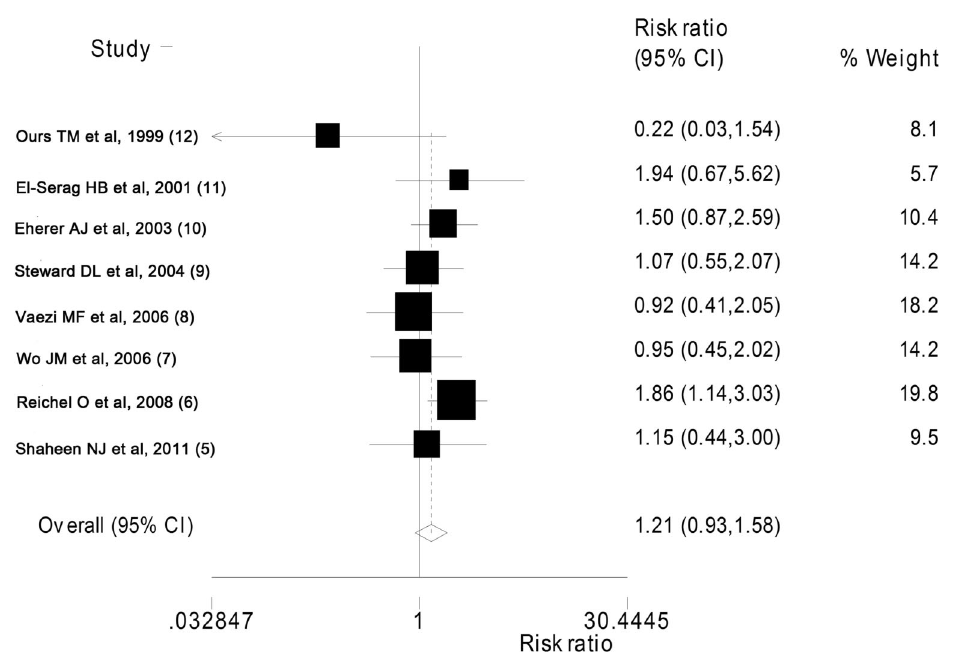
Figure 2. Forest plot showing the effect of PPIs on improvement in LPR symptoms. See Table 1 for reference